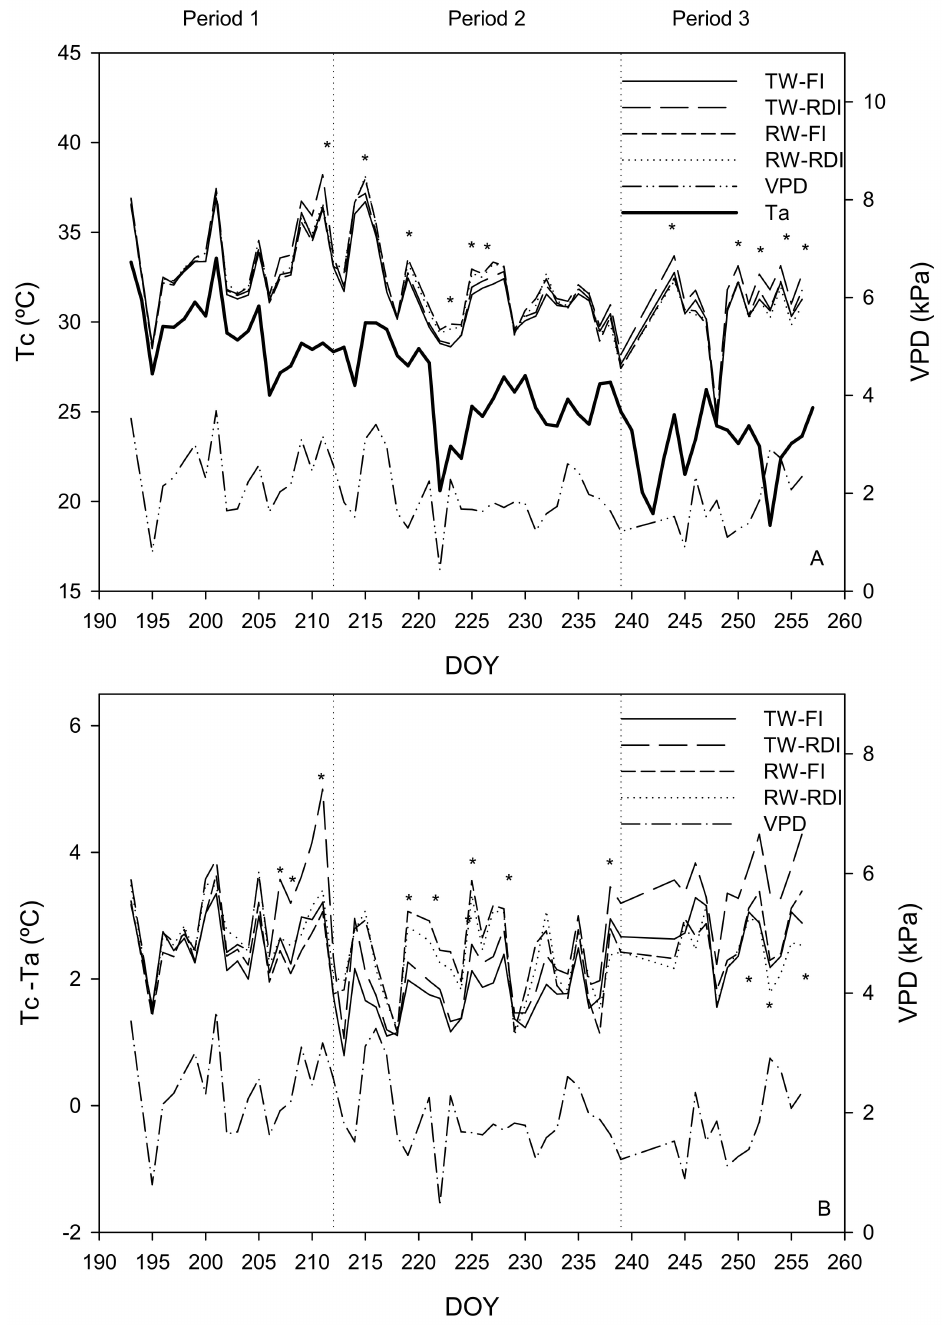
Figure 8. Evolution of ( A ) temperature of canopy (Tc, ◦ C), ( B ) difference between Tc-Ta (Tc-Ta, ◦ C), (C) crop water stress index (CWSI) collected at 10.00 GMT and (D) stem water potential ( Ψ stem , MPa) for each treatment: TW-FI (transfer water-full irrigation), TW-RDI (transfer water-regulated deficit irrigation), RW-FI (reclaimed water-full irrigation), and RW-RDI (reclaimed water-regulated deficit irrigation) during the experimental period. Each value is the average of four individual measurements per tree and replicate. * Indicates significant differences among treatments, according to Tukey’s test ( P < 0.05). The discontinuous vertical lines divide the experimental period into three periods with a different water stress level: 1 (DOY 193-212), 2 (DOY 213-239), and 3 (DOY